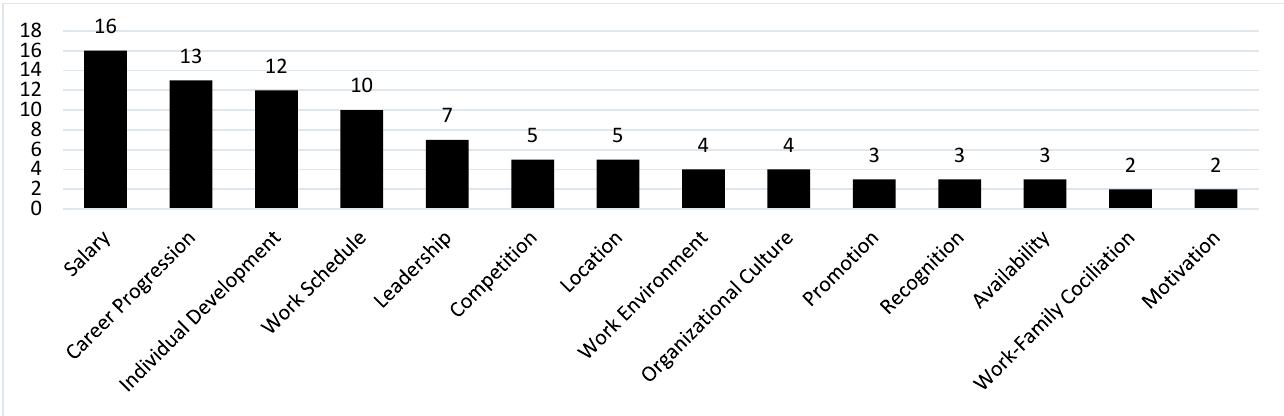
Figure 1. Dimensions of Churning. Source: The authors.